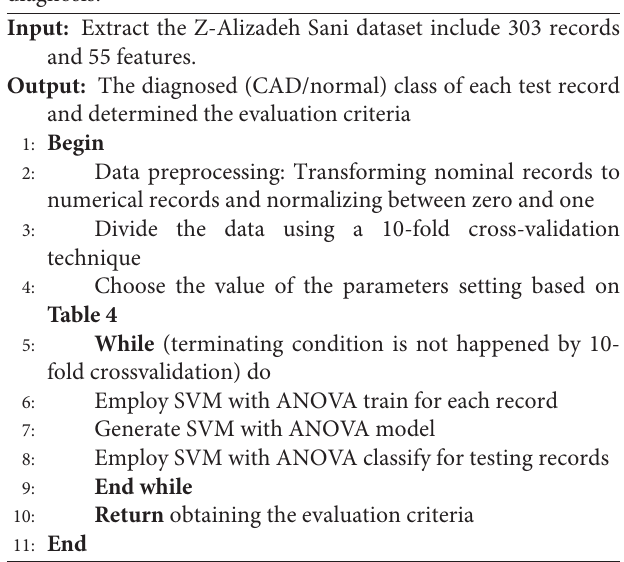
Algorithm 3 : The used SVM with ANOVA method for CAD diagnosis.